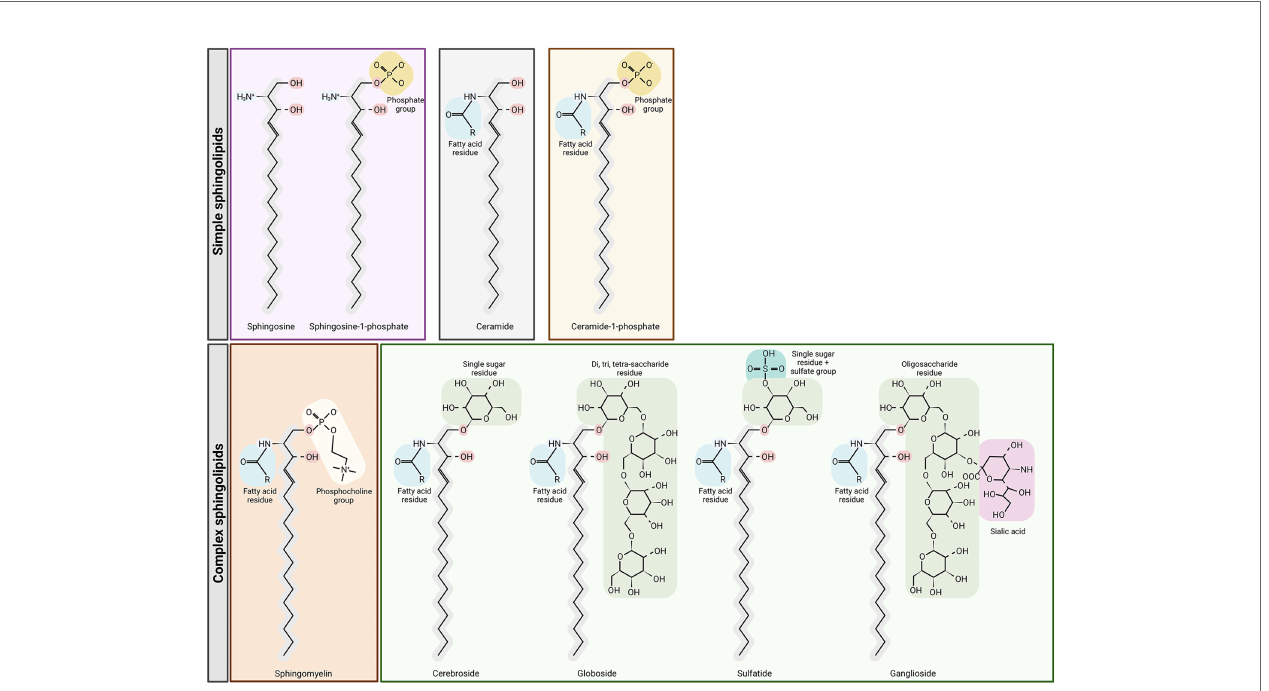
FIGURE 1 | Structures of sphingolipids. Sphingosine is the base for simple sphingolipids. Ceramide contains a fatty acid residue. The addition of a phosphate group to sphingosine or ceramide yields sphingosine-1-phosphate and ceramide-1-phosphate, respectively. Complex sphingolipids are synthesized through ceramide modi fi cations. The addition of a phosphocholine group to ceramide yields sphingomyelin, but the addition of glucose or galactose to ceramide yields glycosphingolipids and sulfatides. Figure created with